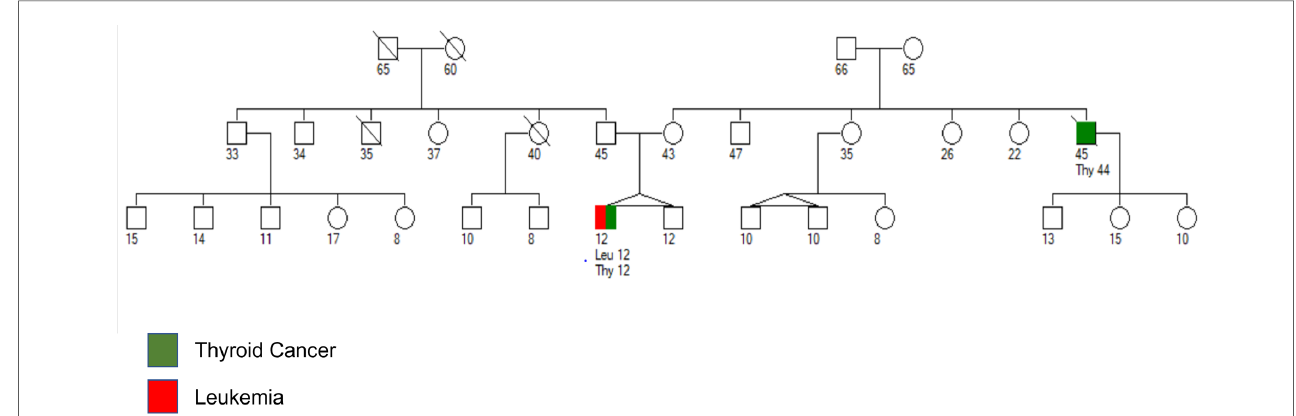
FIGURE 1 Pedigree chart with age of the patient and family members in years. Maternal uncle was diagnosed with anaplastic thyroid cancer at the age of 44 years and died from metastatic disease at the age of 45 years. Patient was diagnosed with papillary thyroid carcinoma and B-ALL at the age of 12